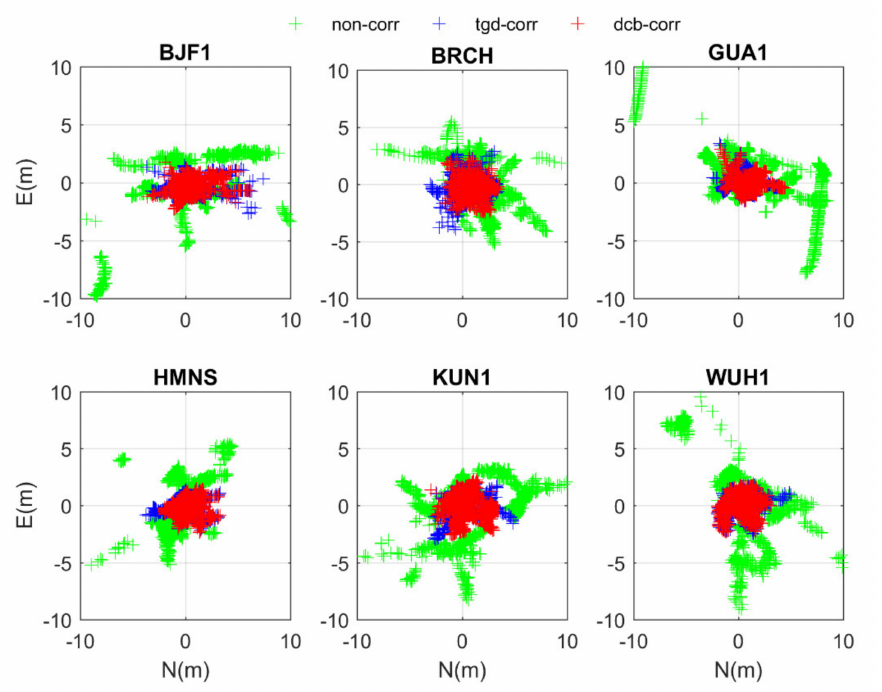
Figure 9. Horizontal positioning error scatters with and without TGD or DCB correction of B2a SPP at six stations.